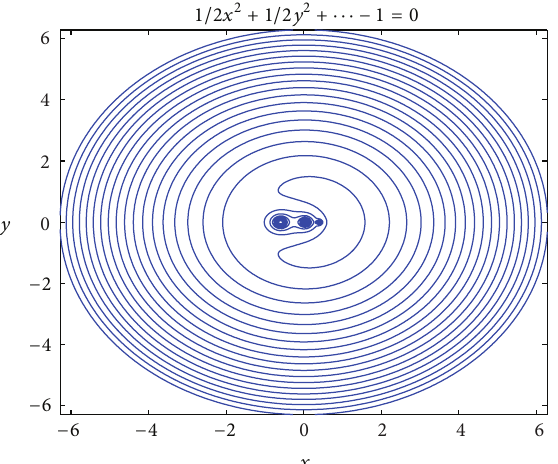
Figure 15: Curve of zero velocity (Kruger60-1) 𝑞 1 = 0.99998 , 𝑞 2 = = 0,𝐴 = 0 . 0.99996 , and 𝐴 1 2